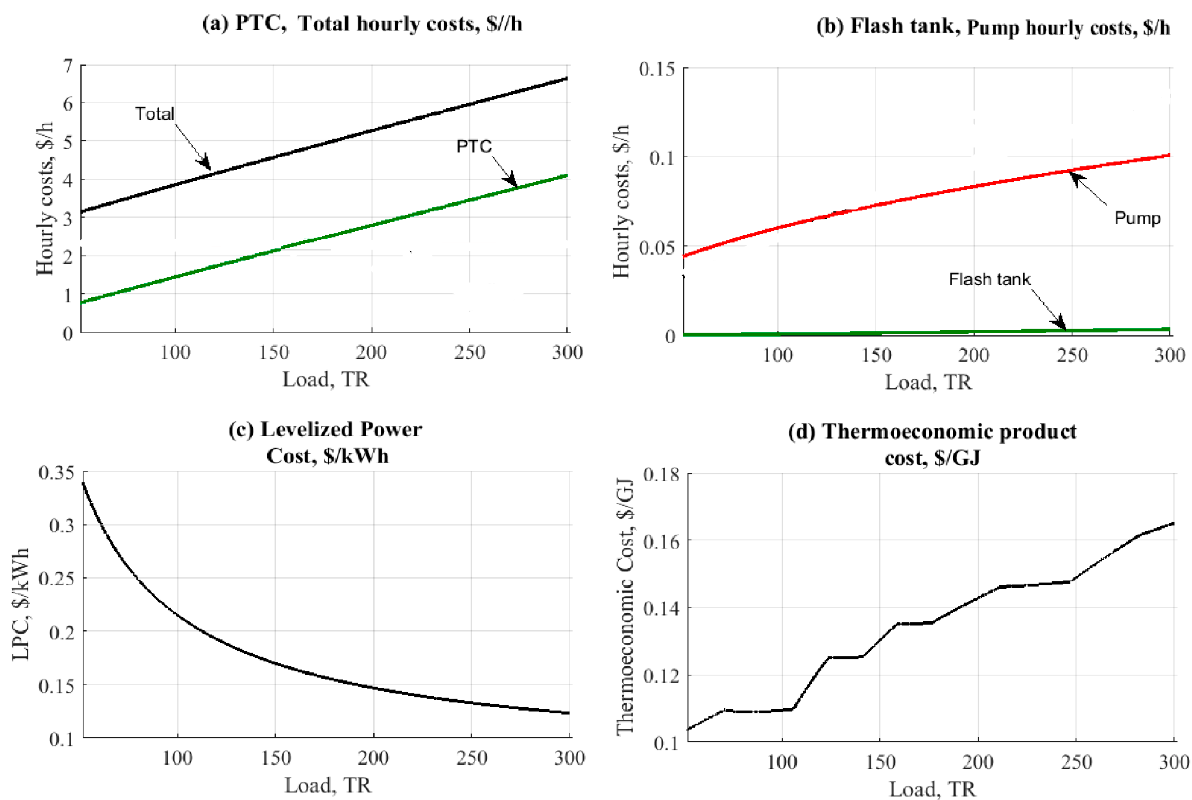
Figure 5. Data results for PTC ‐ H2O ‐ LiBr cycle vs. change in cooling load. ( a )PTC total hourly cost. ( b )Flash tank and pump hourly cost. ( c )Levelized power cost. ( d )Thermo ‐ economic product.